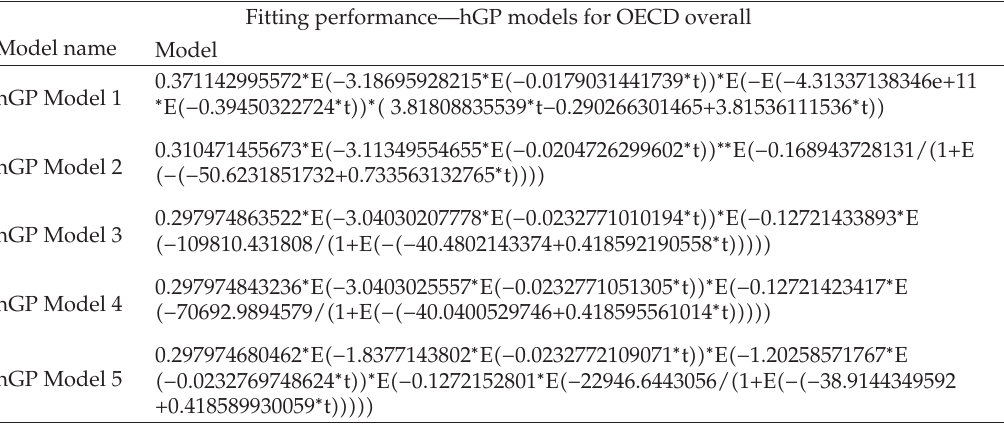
Table 21: Representation of the first five produced hGP models in fitting (cid:2) OECD overall (cid:3) . Fitting performance—hGP models for OECD overall